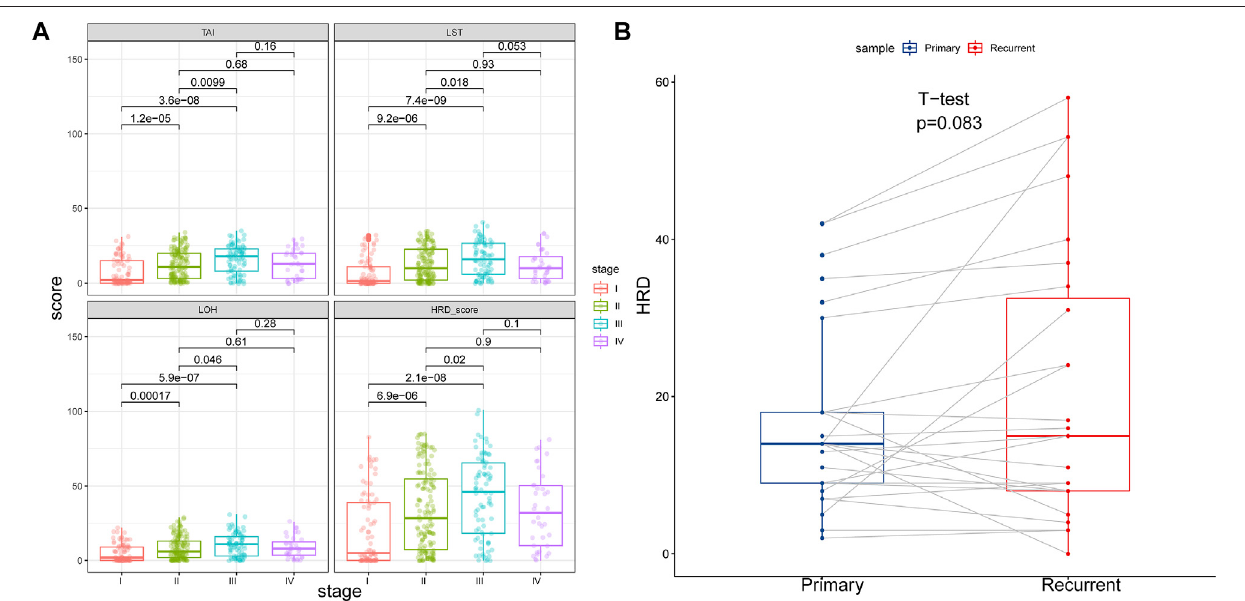
FIGURE 1 |(A) HRD component scoresand combined score in different tumor stage. HRD component scores and combined score were higher in stage II than in stage I,higherinstageIII thaninstageI,andhigher instageIIIthan instageII( p < 0.05).HRDcomponentscoresand combined scoreweresimilarbetweenstageIVand stage III, and similar between stage IV and stage II( p > 0.05). (B) HRD combined score in primary and recurrent tumor samples. Recurrent tumor tissues showed similar HRD combined score with the primary counterpart ( p (cid:1)